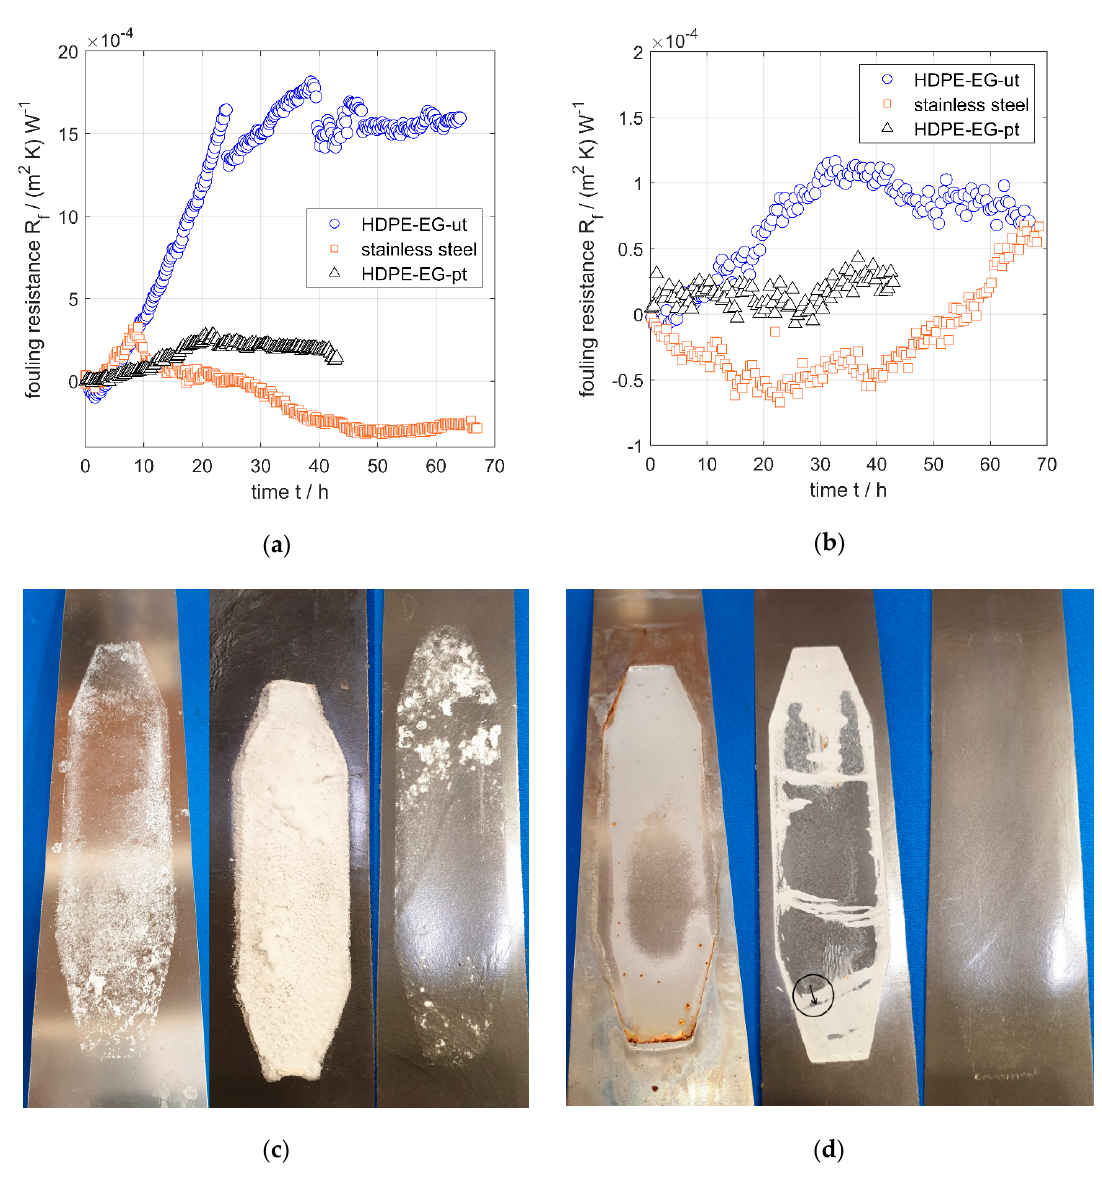
Figure 8. Measured fouling resistance due to crystallization fouling of ( a ) CaSO 4 , ( b ) mixed salts from seawater on the investigated heat transfer films. w = 45 g/kg; q = 35 kW / m 2 ; Tb = 30 ◦ C; Resol = 3100, ( c ) scaling layer of CaSO 4 and ( d ) scaling layer caused by artificial seawater on stainless steel 1.4301 (left), HDPE-EG-ut (middle), HDPE-EG-pt (right).